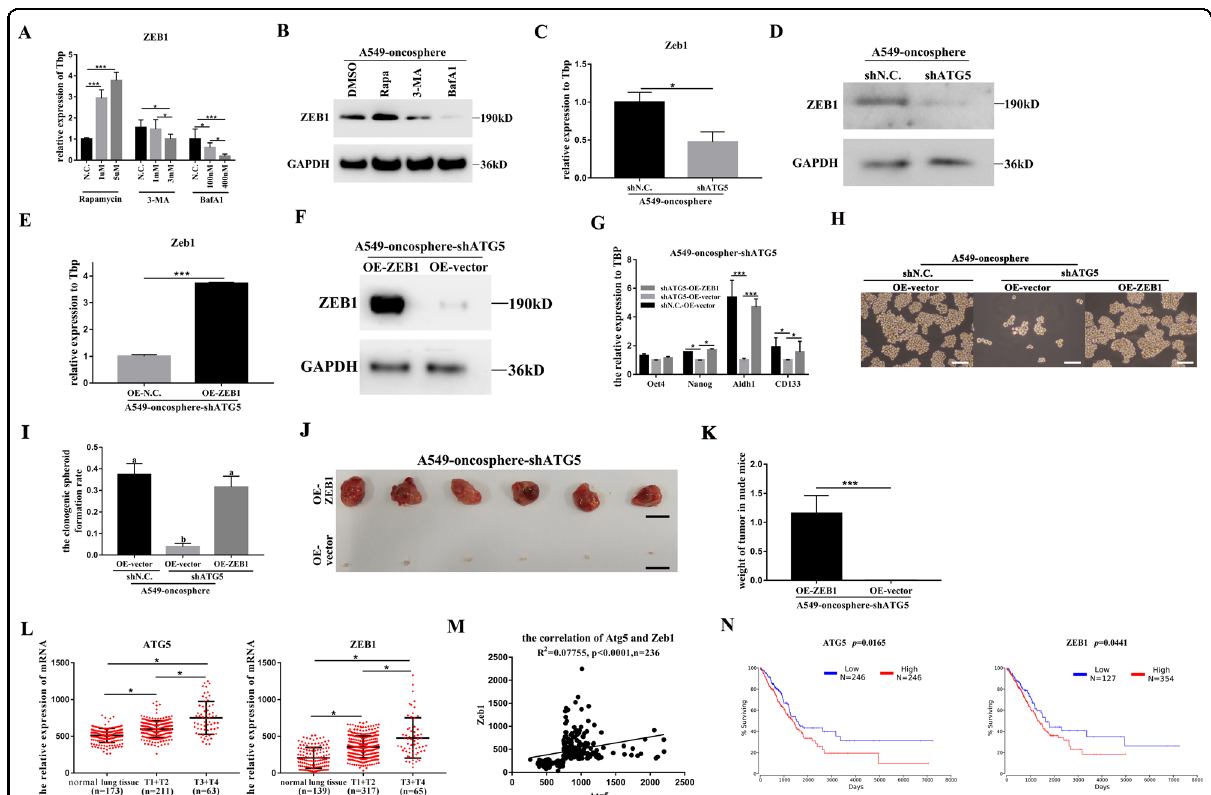
Fig. 6 Augmentation of the stemness of human lung CSCs requires cooperation of Zeb1 in A549-oncosphere and analysis of clinical relevance of ATG5 and Zeb1. A – D Analysis of mRNA expression and protein level of Zeb1 in A549-oncosphere treated by DMSO, rapa, 3-MA, and BafA1 A , B ; and upon silencing of ATG5 C , D ; Tbp and GAPDH were used as reference controls, * p <0.05. The concentrations of 3-MA, BafA1, and rapa were 3mM, 100nM, and 5µM, respectively, and cells in Fig. 6B were treated for 24h. E , F Analysis of mRNA expression and protein level of Zeb1 in A549-oncosphere- shATG5 after overexpression of Zeb1 (A549-oncosphere-shATG5-OE-ZEB1); Tbp and GAPDH were used as reference controls, *** p <0.01. G Analysis of mRNA expression of Oct4, Nanog, Aldh1, and CD133 in A549-oncosphere-shN.C.-OE-vector, A549-oncosphere-shATG5-OE-vector, and A549-oncosphere- shATG5-OE-ZEB1; Tbp was used as a reference control, * p <0.05, *** p <0.01. Colony formation assay ( H bar = 120µm) and single-cell cloning assay ( I different superscripts represent signi fi cant differences, p <0.05), using A549-oncosphere-shN.C.-OE-vector, A549-oncosphere-shATG5-OE-vector, and A549- oncosphere-shATG5-OE-ZEB1 cells. J , K Analysis of the tumors obtained from mice receiving A549-oncosphere-shATG5-OE-vector and A549-oncosphere- shATG5-OE-ZEB1, *** p <0.01. Bar = 1 cm. L mRNA expression of ATG5 and ZEB1 in normal tissue and different stages of human lung adenocarcinoma using TCGA data sets, * p <0.05. M Analysis of the correlation of ATG5 and ZEB1 in human lung adenocarcinoma using TCGA datasets; R 2 was the correlation coef fi cient. N Survival analysis of ATG5 and ZEB1 in human lung adenocarcinoma using TCGA datasets by